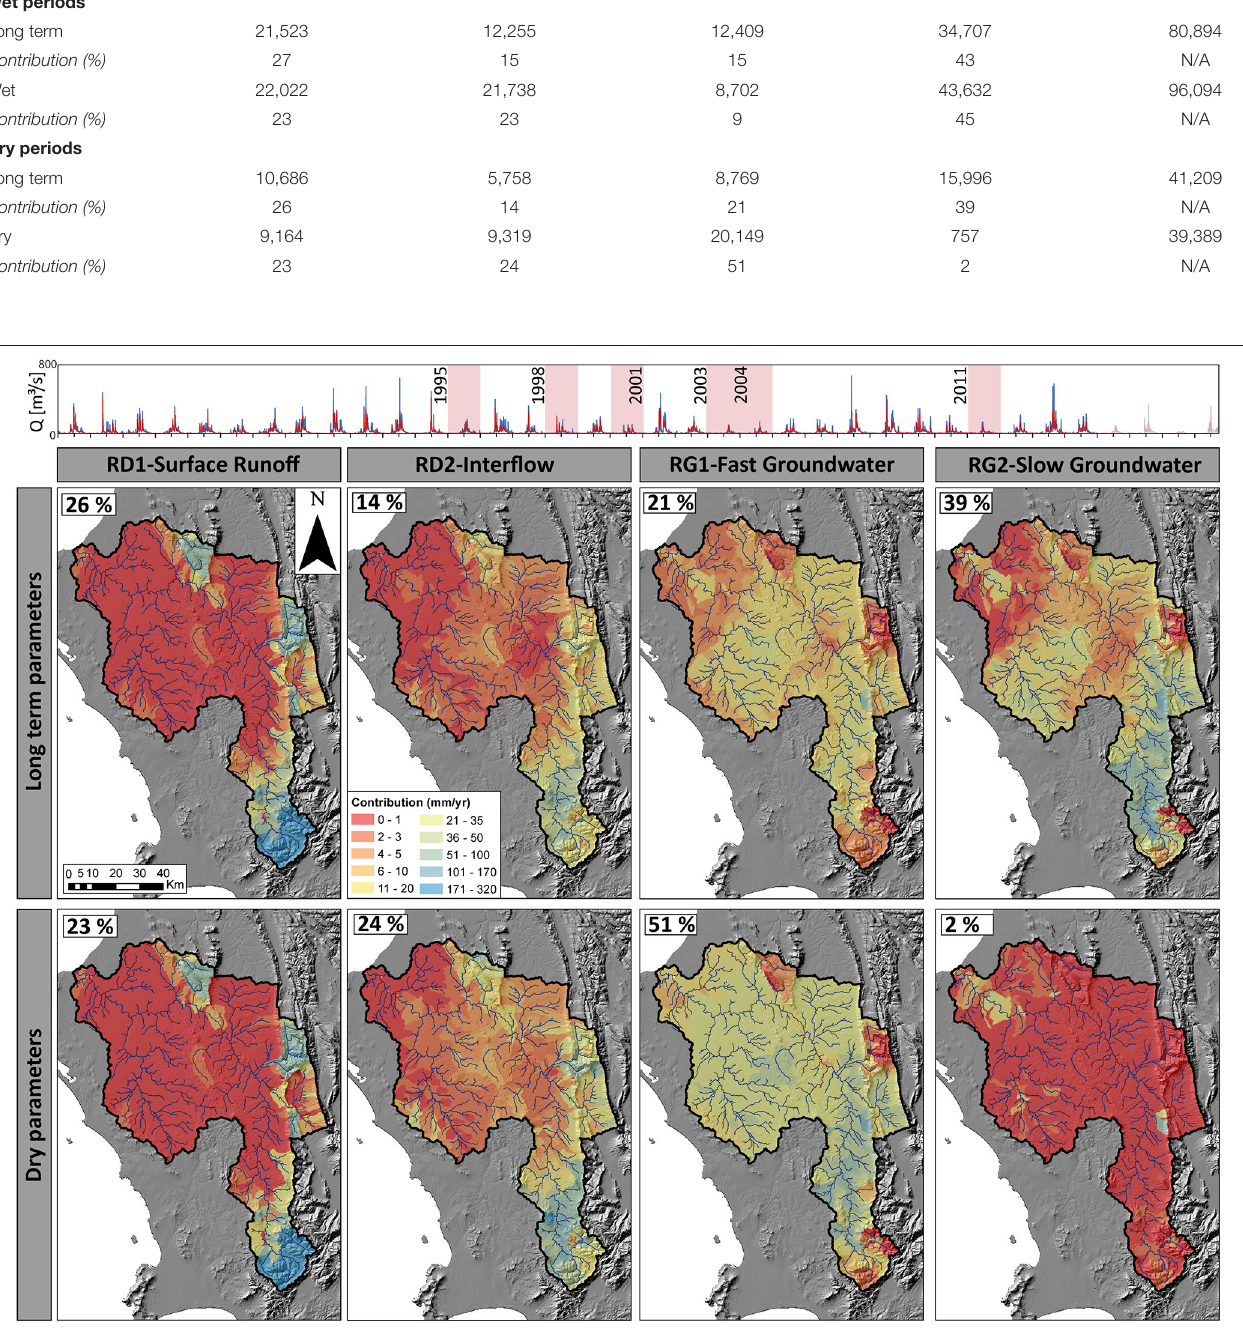
Frontiers in Climate |